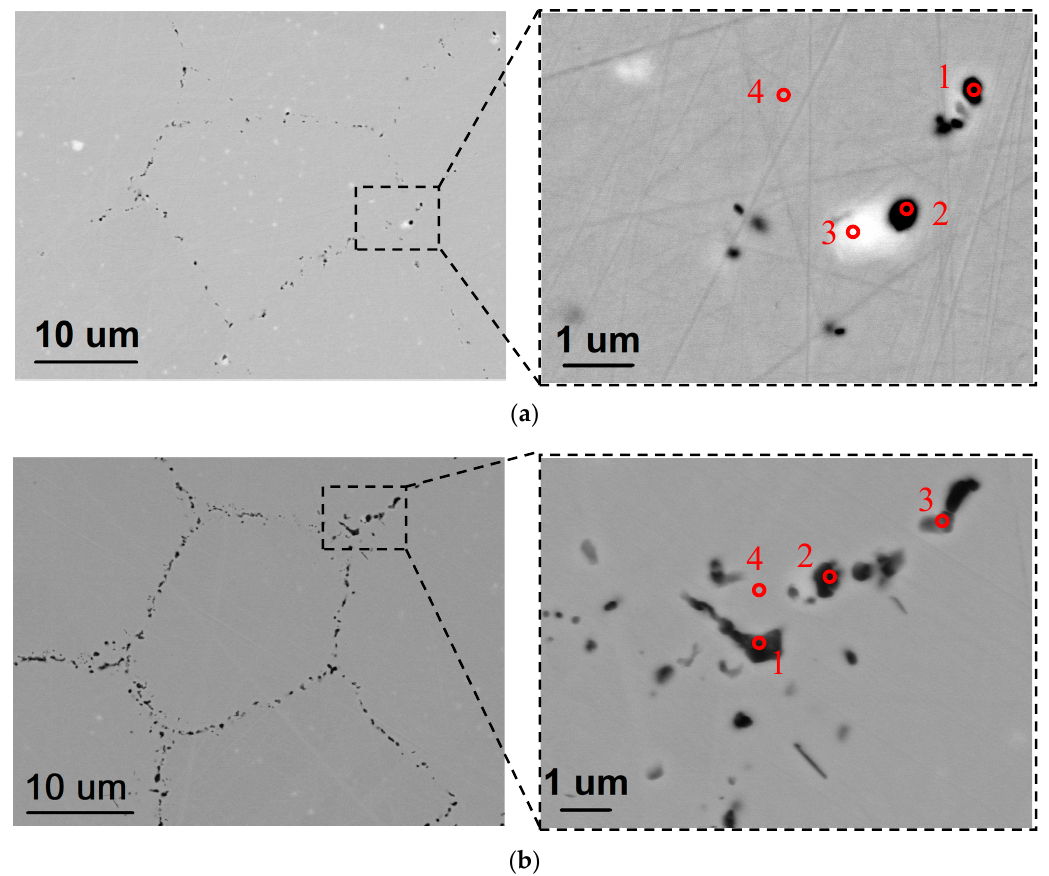
Figure 7. BSE images of the residues formed in IN718 alloys consolidated by SPS with the pre-oxidized powders at 800 °C for 5 min in vacuum ( a ) and in air ( b ). Table 3. Results of EPMA WDS point analysis obtained from the residues marked in Figure 7a, and b, respectively (in atom %).